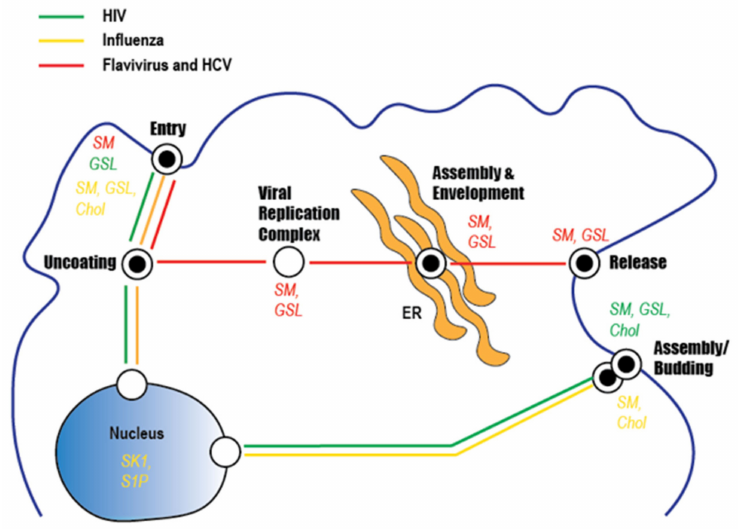
Figure 6. Sphingolipid involvement in the infection cycle of clinically important viruses. The three lines indicate the steps involved in the replication of HCV and flaviviruses (red), HIV (green), and influenza virus (yellow). Reported roles for lipids (sphingomyelin [SM], glycosphingolipids [GSL], and / or cholesterol (Chol)) in the lifecycle of each virus are